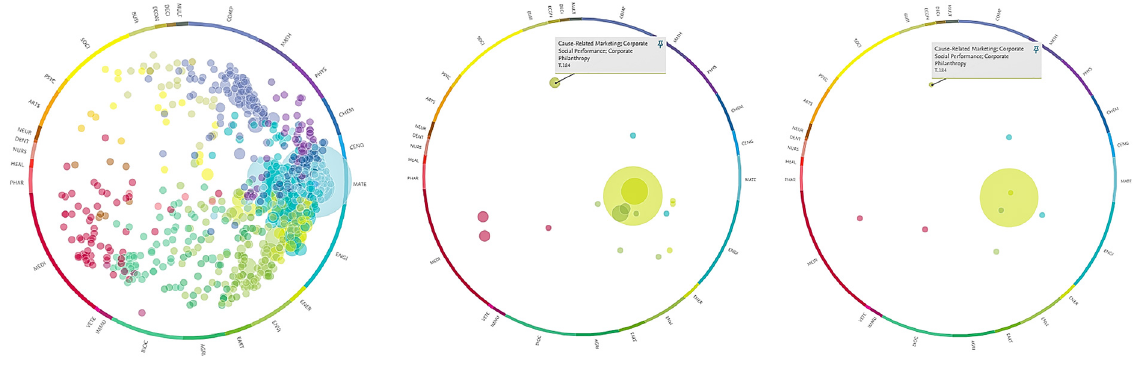
Figure D1. Top 1% topics in each research area SDG 7, SDG 7 and Investment, SDG 7 and